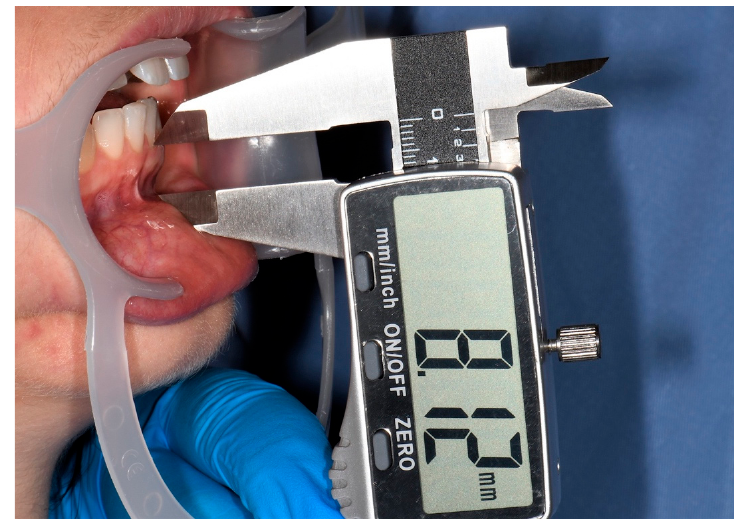
Figure 5. Measurement of depth of vestibular fornix .